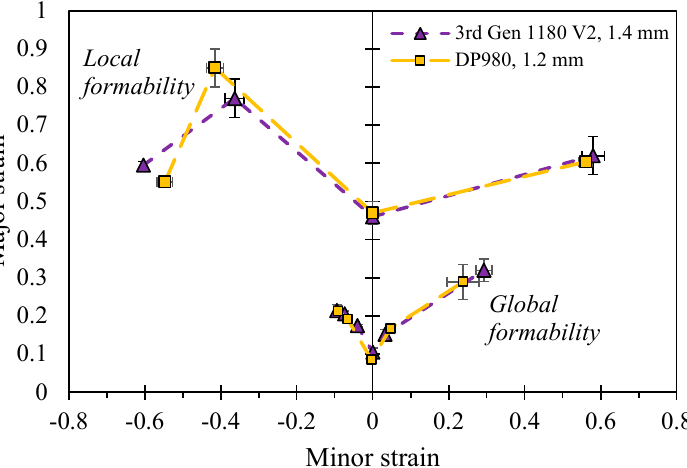
Figure 31. Comparison of the local and global formability in strain space for the 3rd Gen 1180 V2 and the DP980.